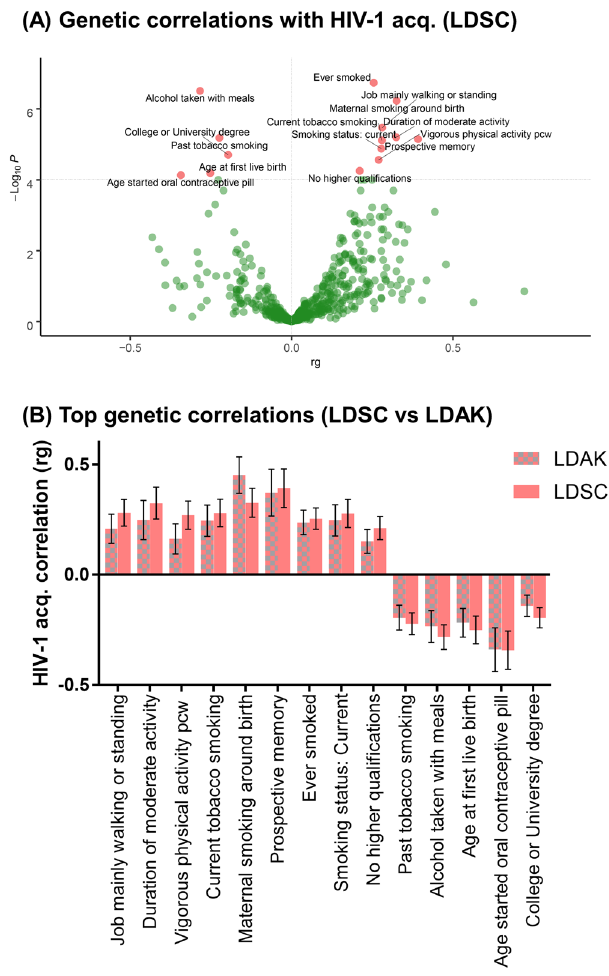
Figure 1. Genetic correlations between HIV-1 acquisition susceptibility and traits tested within the UK Biobank. (A) Correlations performed within LD Hub using the LDSC model to determine genetic correlations between HIV-1 acquisition and 516 heritable traits. The Bonferroni-significant correlations (rg) are displayed in red and delimited by the horizontal line (P = 0.05/516 traits = 8.38 × 10 − 5 ). (B) Validation of the Bonferroni- significant findings using SumHer-GC, which is based on the LDAK model, adjusting for genomic control. The correlation values observed for the 14 Bonferroni-significant traits associated with HIV-1 acquisition in the LDSC method were highly concordant with results using the LDAK method (Pearson’s r = 0.98, P = 2.59 × 10 − 9